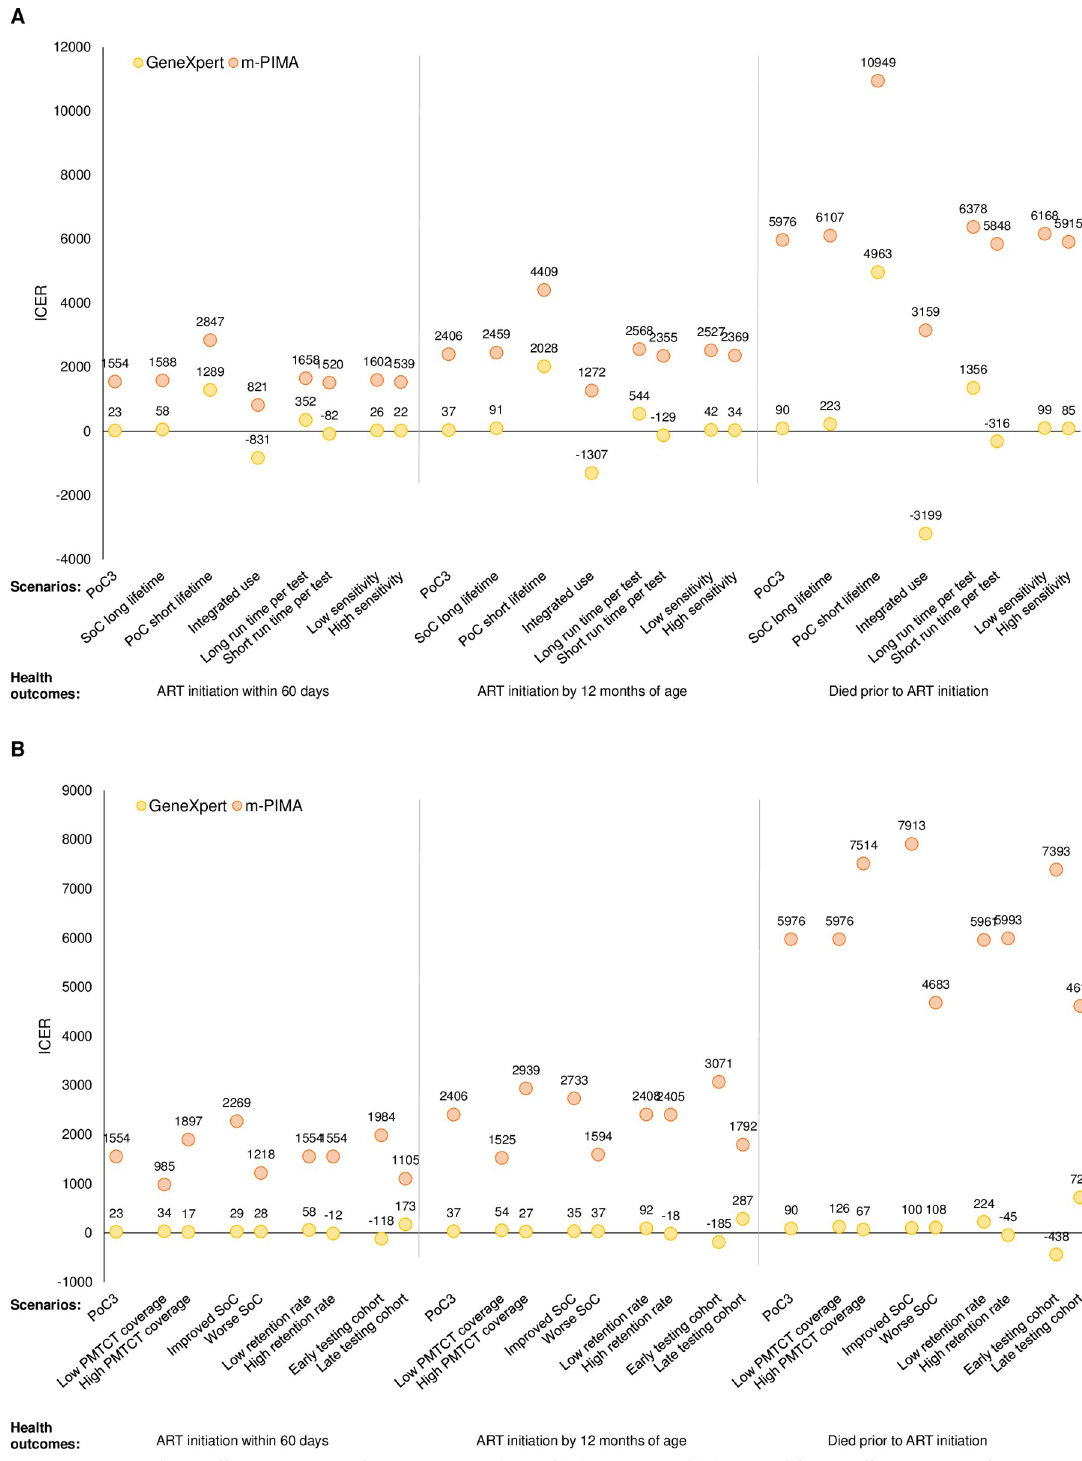
Fig 4. Incremental cost-effectiveness ratios for sensitivity analyses of (A) intrinsic and (B) external factors affecting point-of-care testing. ART: antiretroviral therapy; ICER: incremental cost-effectiveness ratio; PoC: point-of-care testing; SoC: standard of care testing. Note: All sensitivity analyses were performed with the PoC3 algorithm and primary implementation model. For (A) and (B), PoC3 represents the results from the primary analysis with the baseline model parameters. For (A) PoC short lifespan refers to the time period covered by the manufacturer’s warranty; integrated use refers to use of the PoC machines across programs (HIV viral load and tuberculosis testing);